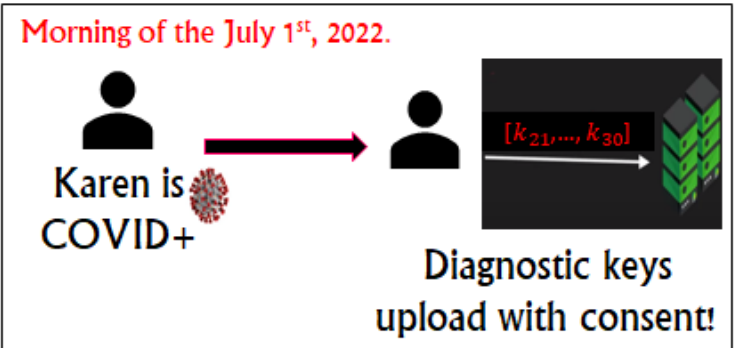
Figure 5. Example of uploading keys to exposure server after